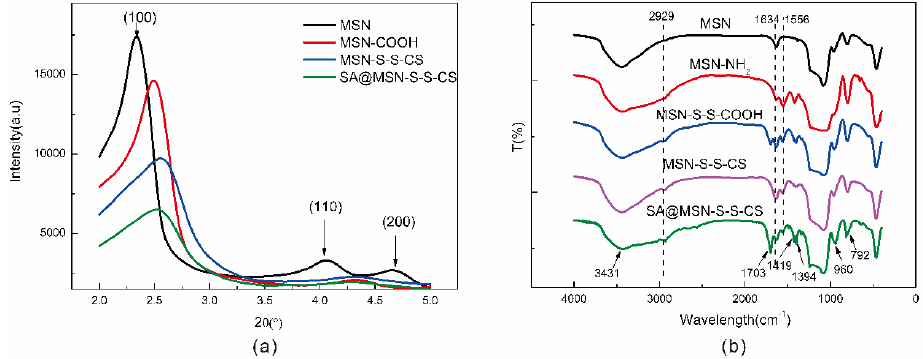
Figure 4. XRD diffraction pattern of MSN and its composites ( a ); FTIR spectra of MSN, MSN-NH 2 ,